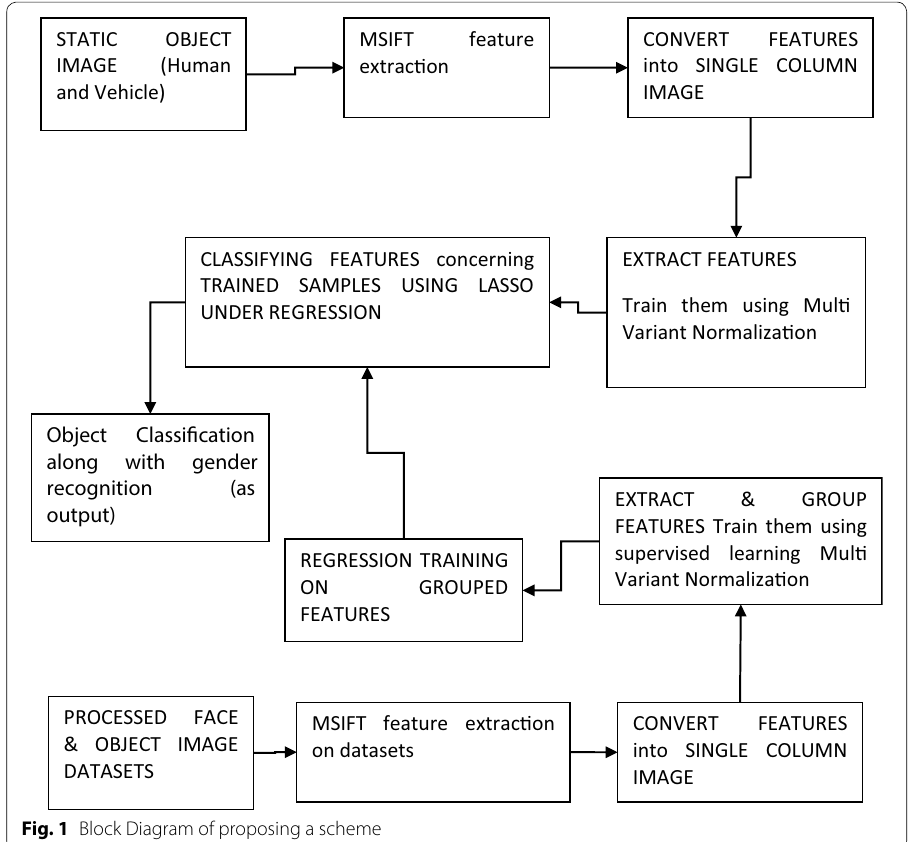
Fig. 1 Block Diagram of proposing a